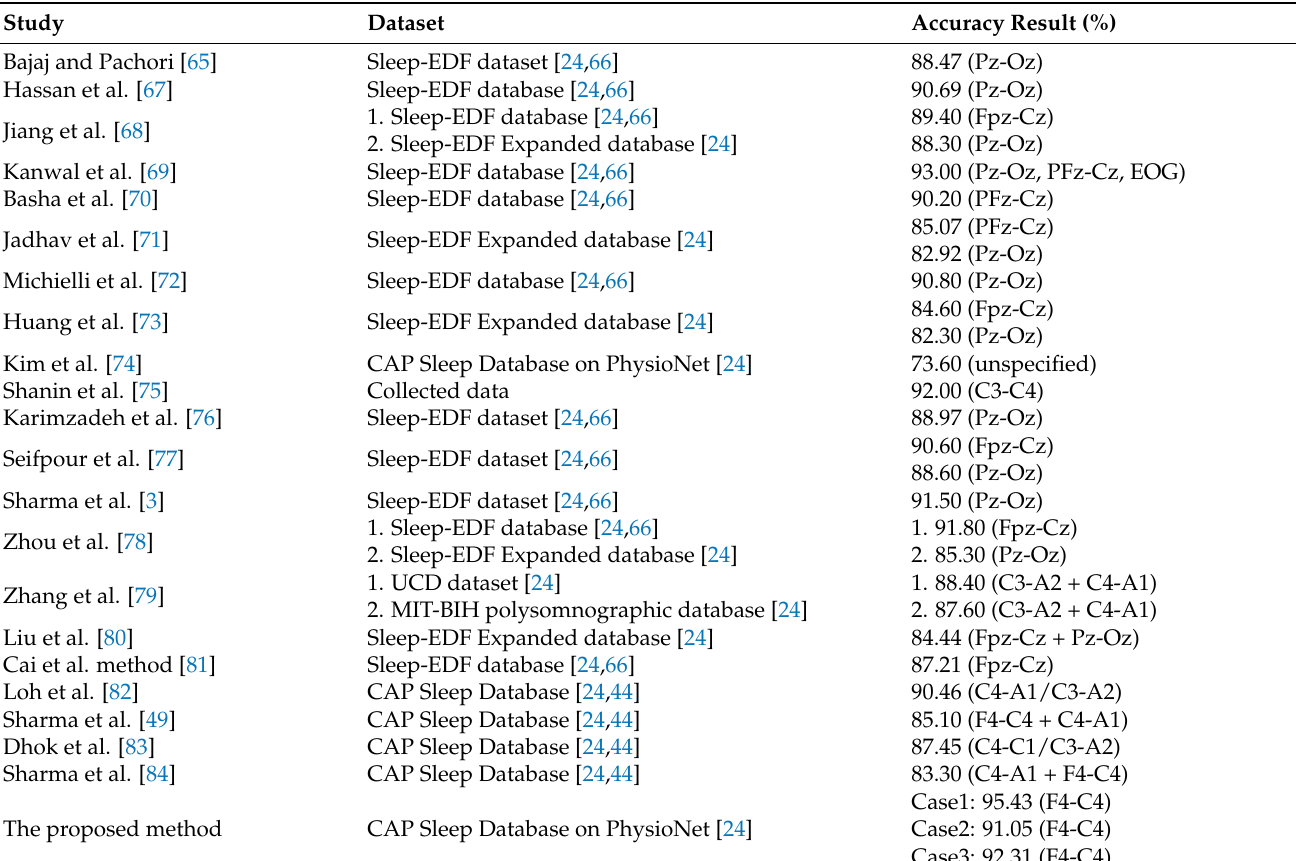
Table 7. The comparison